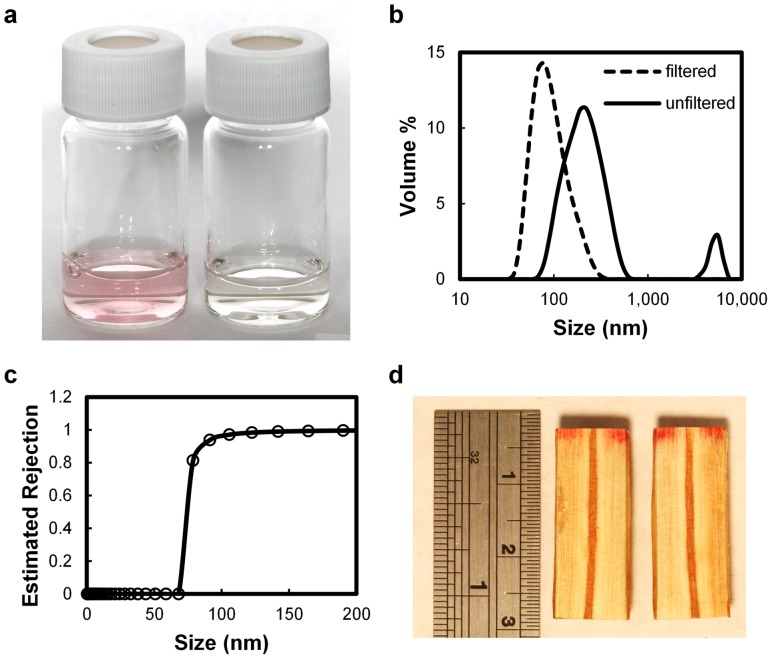
Filtration performance of the xylem filter.a) Feed solution of a pigment dye before filtration (left), compared to the filtrate (right). b) Size distribution of the pigment particles in the feed and filtrate solutions measured by dynamic light scattering. c) Dependence of the rejection on the particle size estimated from the data in (b). d) Cross-section of the xylem filter after filtration. Scale is in centimeters and inches.